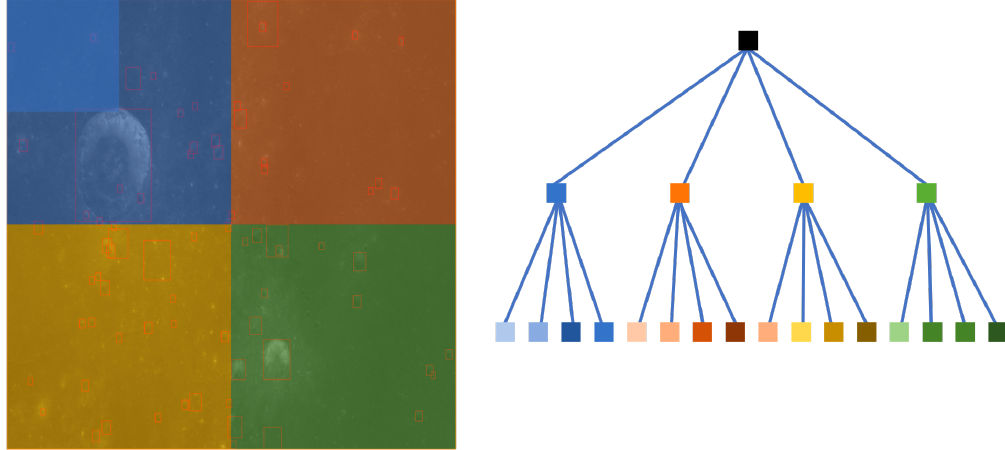
Figure 9. Tree decomposition of Chang’e